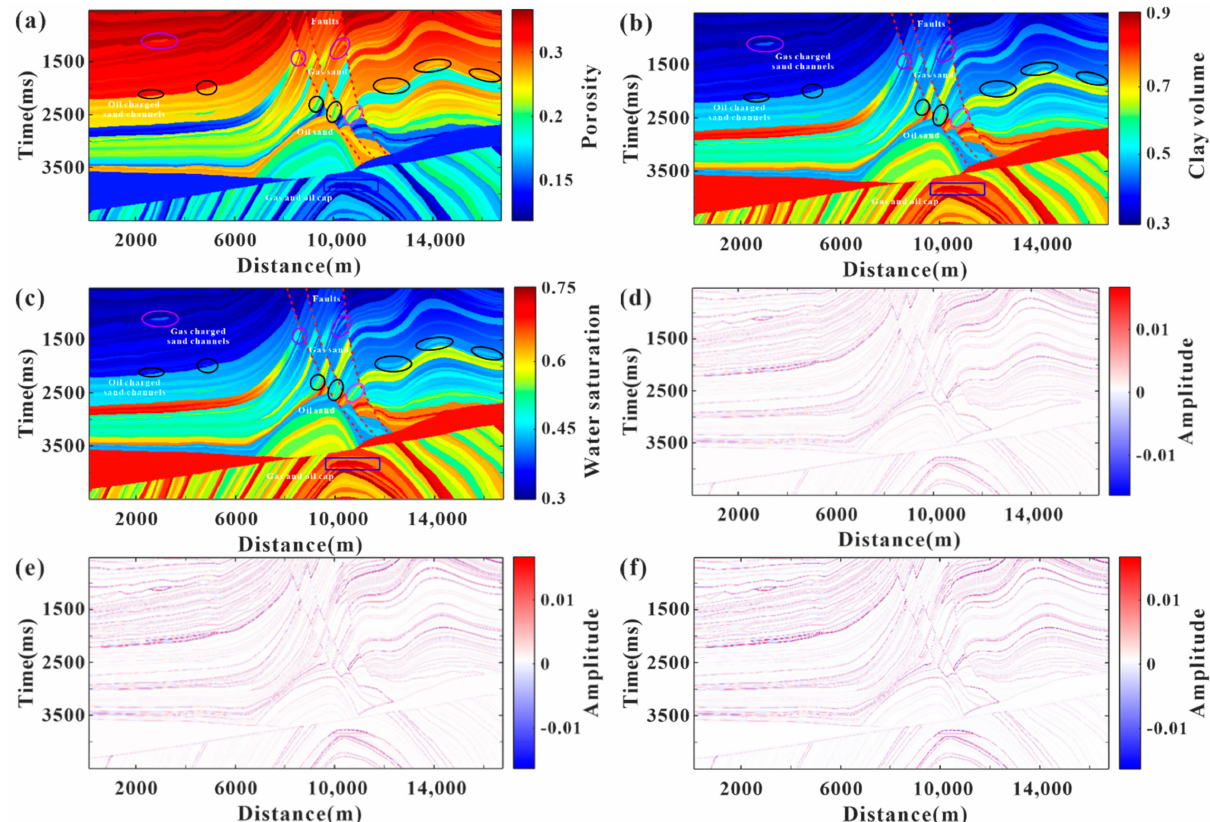
Figure 9. Part of Marmousi2 model data and seismic data from different center angles: ( a ) porosity, ( b ) clay volume, ( c ) water saturation, ( d ) 7 ◦ , ( e ) 18 ◦ , ( f ) 26 ◦